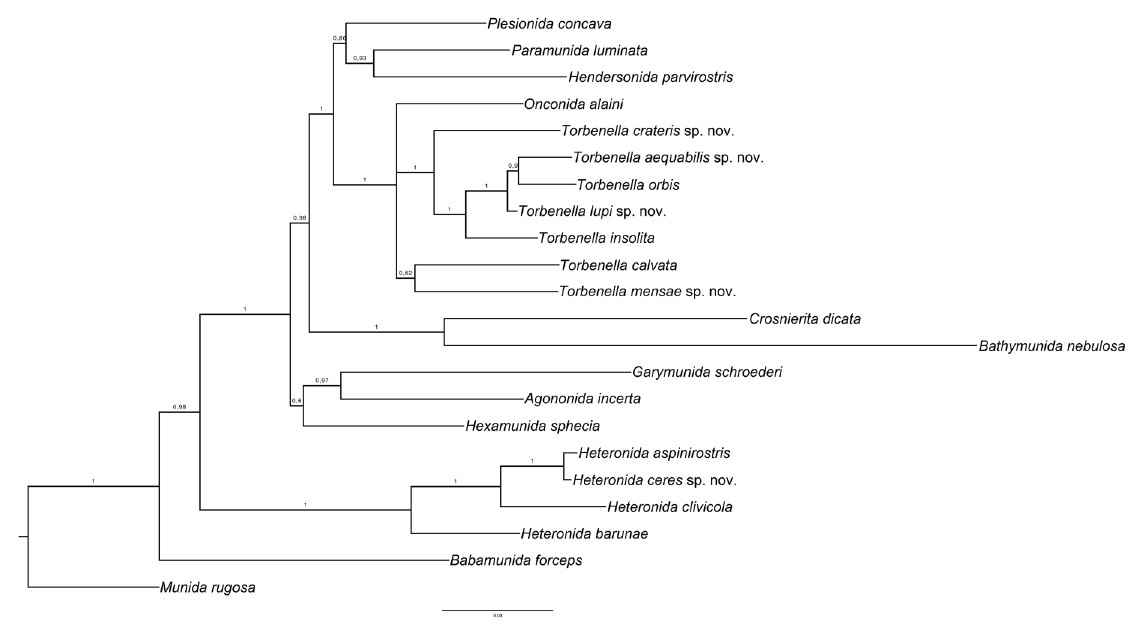
Fig. 7. Bayesian phylogenetic inference based on four concatenated gene fragments (COI, 16S, 18S and PEPCK). Numbers on branches indicated the posterior probability